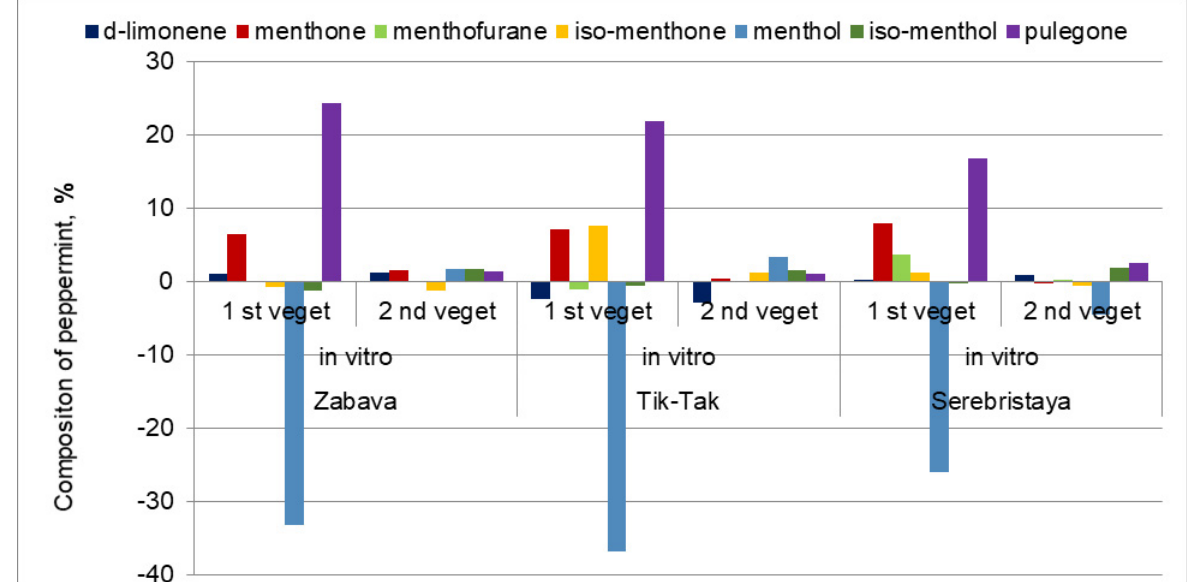
Figure 3. Differences in the content of individual components of EOs extracted from in vitro propagated peppermint cultivars Zabava, Tik-Tak and Serebristaya, which were cultivated in field conditions after acclimation in the 1st (2020) and 2nd (2021) years of vegetation, in comparison with the parental forms grown in the field.